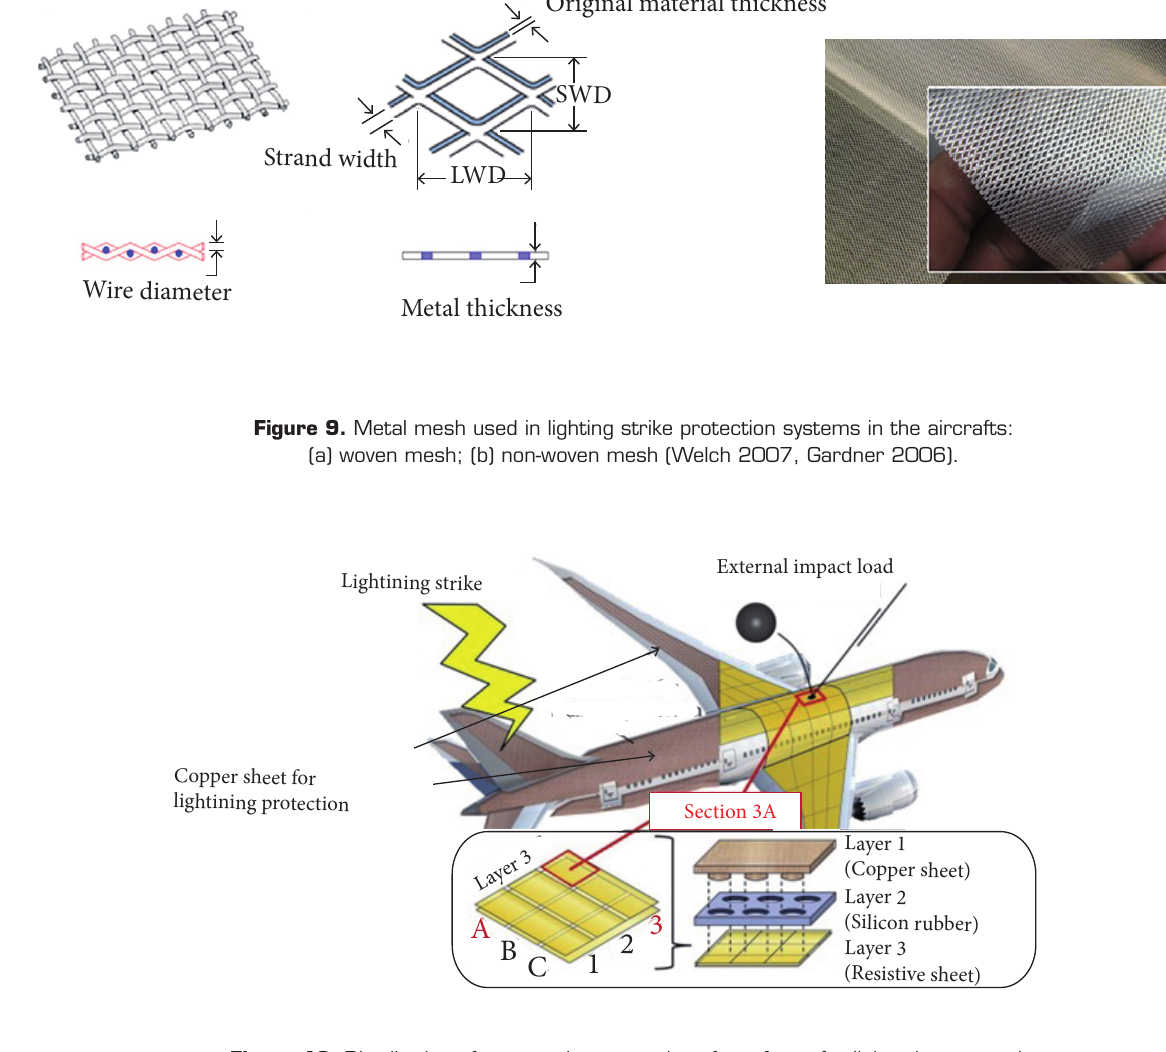
Figure 10. Distribution of copper sheets on aircraft surfaces for lightening protection (Gibson 2010; Al-Saleh and Sundararaj